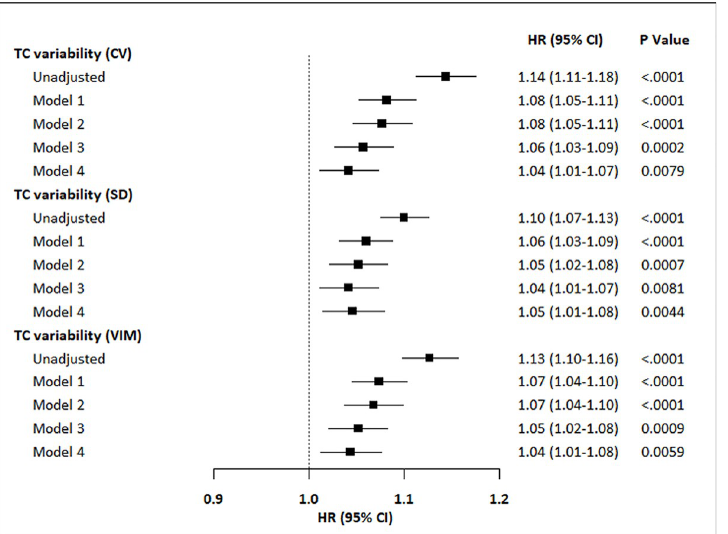
Fig 3. Increase in the risk of AF for every 1-SD increase in TC variability in the unadjusted model and models adjusted for risk factors including mean TC level. Model 1: Adjusted for age, sex Model 2: model 1 + income, BMI, hypertension, dyslipidemia, diabetes, smoking, alcohol intake, exercise Model 3: model 2 + heart failure, ischemic heart disease, cerebrovascular disease, chronic kidney disease, thyroid disorder, chronic obstructive pulmonary disease, obstructive sleep apnea Model 4: model 3 + mean total cholesterol Abbreviations: AF, atrial fibrillation; CI, confidence interval; CV, coefficients of variance; HR, hazard ratios; SD, standard deviation; TC, total cholesterol; VIM, variability independent of the